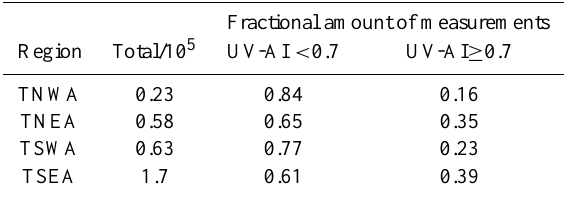
Table 2. Amount of measurements used for the regression analysis in Eq. (1).